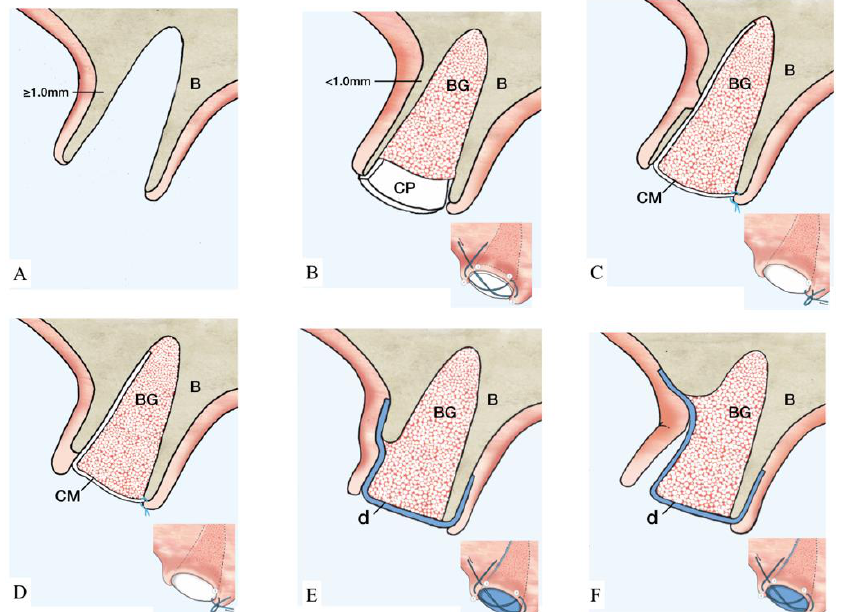
Figure 2. Illustration of ST-Classification with suggested treatment options. ( A ): ST1A. Extraction socket with thick ( ≥ 1 mm) and intact buccal bone. No further treatment is needed. Optionally, a collagen matrix may be placed to facilitate homeostasis. B showed the management of ST1B socket. ( B ): Thin (<1 mm) and intact buccal bone. Suggested treatment option is a particulate grafting material with collagen dressing on the coronal aspect. The collagen plug is secured by a cross suture as illustrated. ( C ): Buccal bone with a bony fenestration regardless of buccal bone thickness. An absorbable membrane (marked in white) is placed inside the socket and, subsequently, particulate grafting material is added. The membrane is sutured to the palatal tissue using single interrupted suture. Treatment for ST3 sockets is reported in D–F. ( D ): The length of the dehiscence is ≤ 1/3 of buccal bone height. The recommended therapeutic approach coincides with the description of